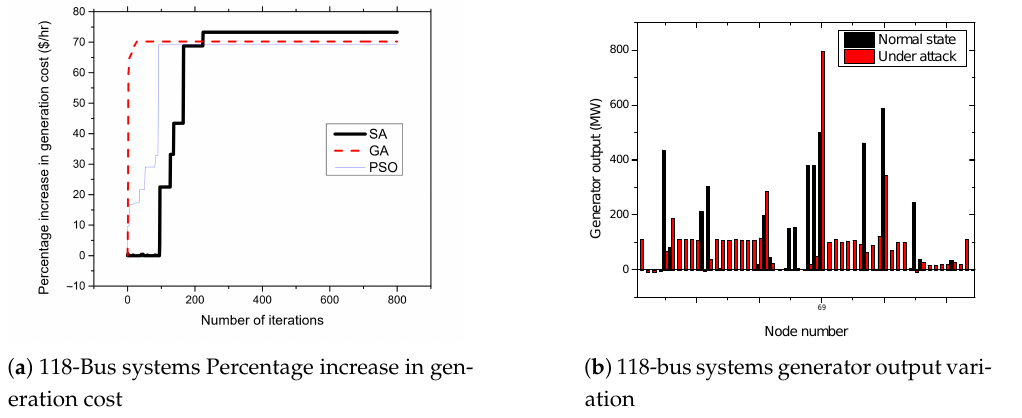
Figure 8. 118-bus systems increase in generation cost and generator output